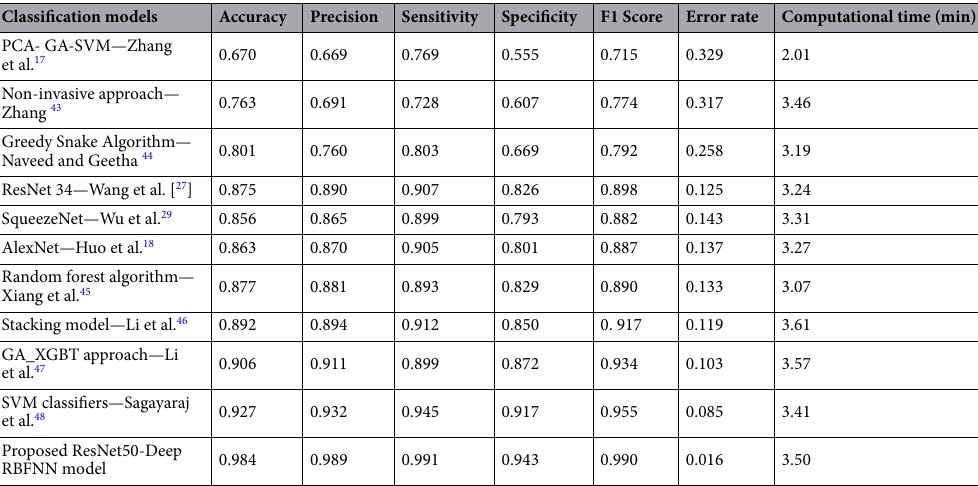
Table 7. Comparative analysis with previous